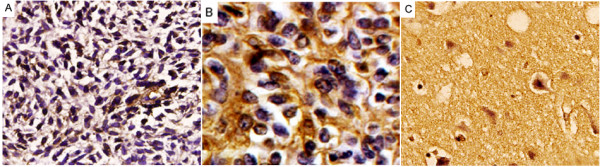
Immunohistochemical staining of SMAD4 protein in tumor cells of GBM (A) and astrocytoma (B) (Original magnification ×400). Staining for this antigen is described in Materials and Methods. Positive staining of SMAD4 is seen in the cytoplasm and/or nuclei of tumors cells and is more abundant in the low- (B) than the high-grade (A) tumors. Intensively positive expression of SMAD4 (C) was observed in normal brain tissues.